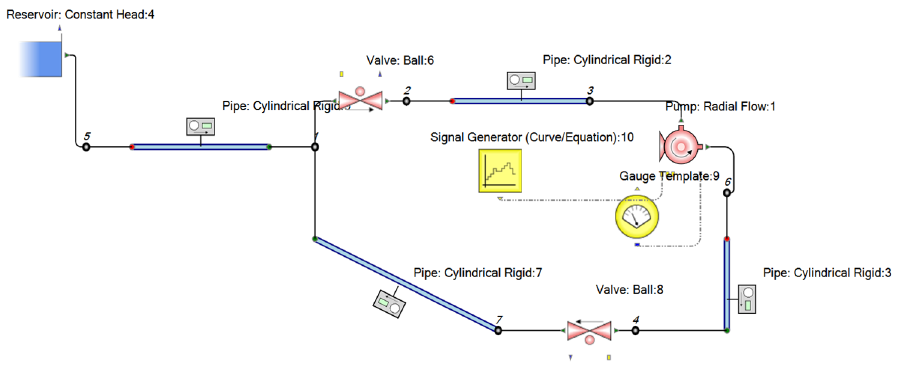
Figure 4. Flomaster simulation experiment platform of centrifugal pump.